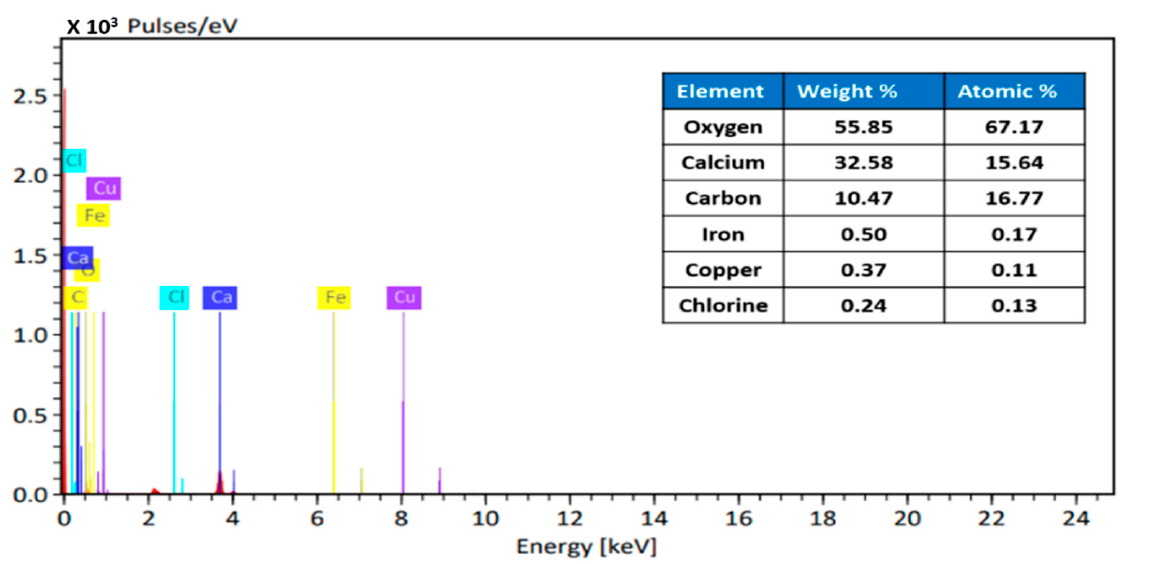
Figure 4. EDX of Fe–Cu/Alg-LS nanocomposite.